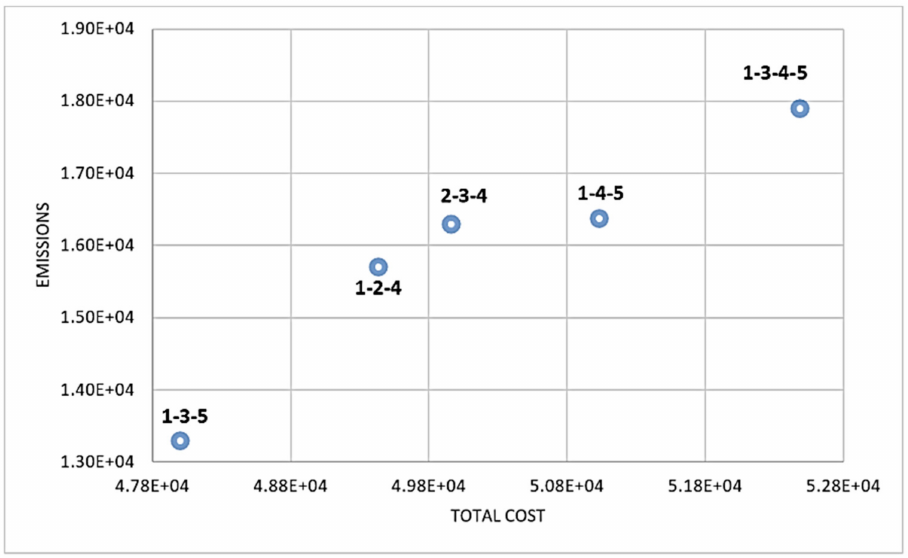
Figure 11. The non-dominated solutions of cost and emissions.